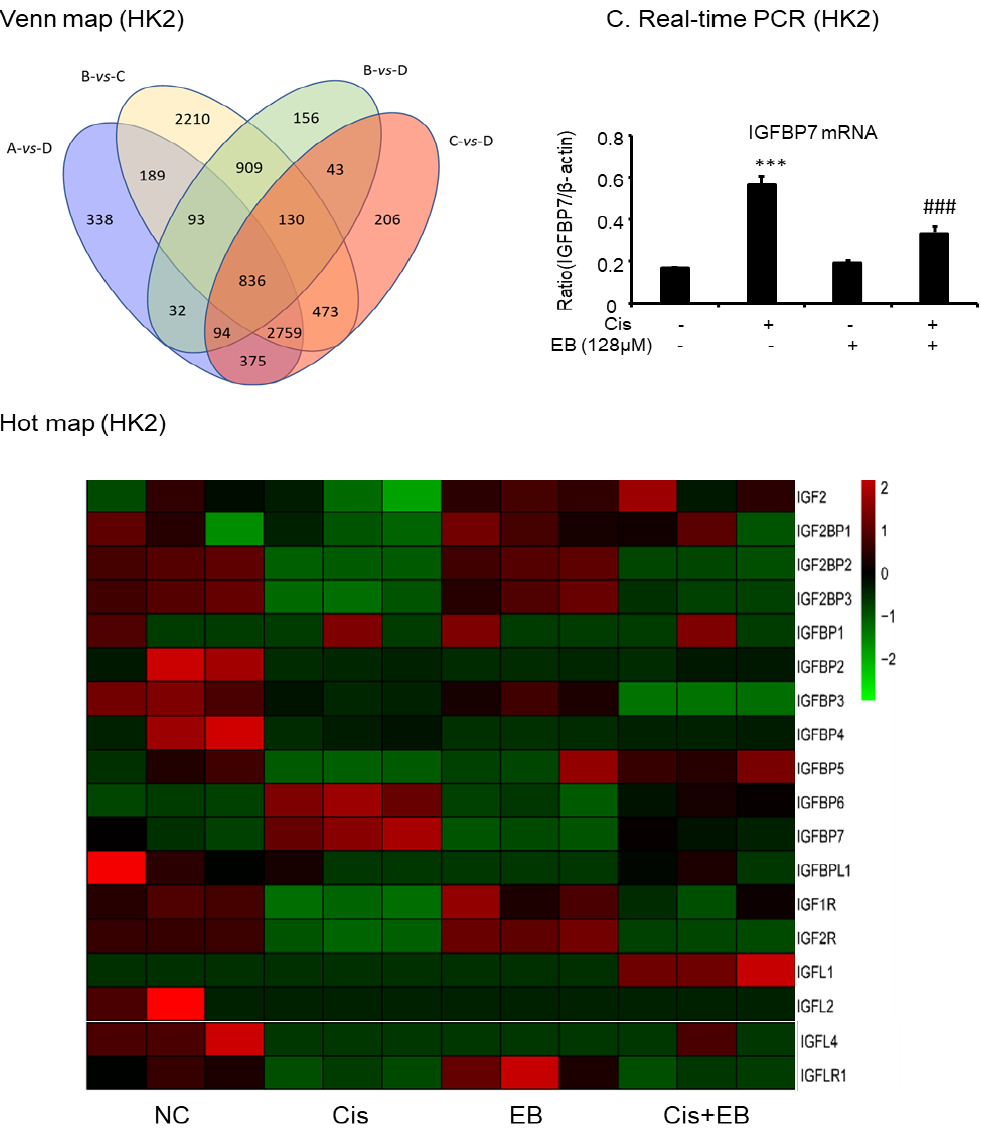
Figure 7. RNA-seq analysis results and verification. ( A ) Venn map of the number of significantly differentially expressed genes. ( B ) Hot map of gene expression related to insulin-like growth factor pathway. ( C ) Real-time PCR of IGFBP-7. Real-time PCR demonstrate that treatment of eleutheroside B largely blocked upregulated mRNA levels of IGFBP-7. *** p < 0.001, ### p <